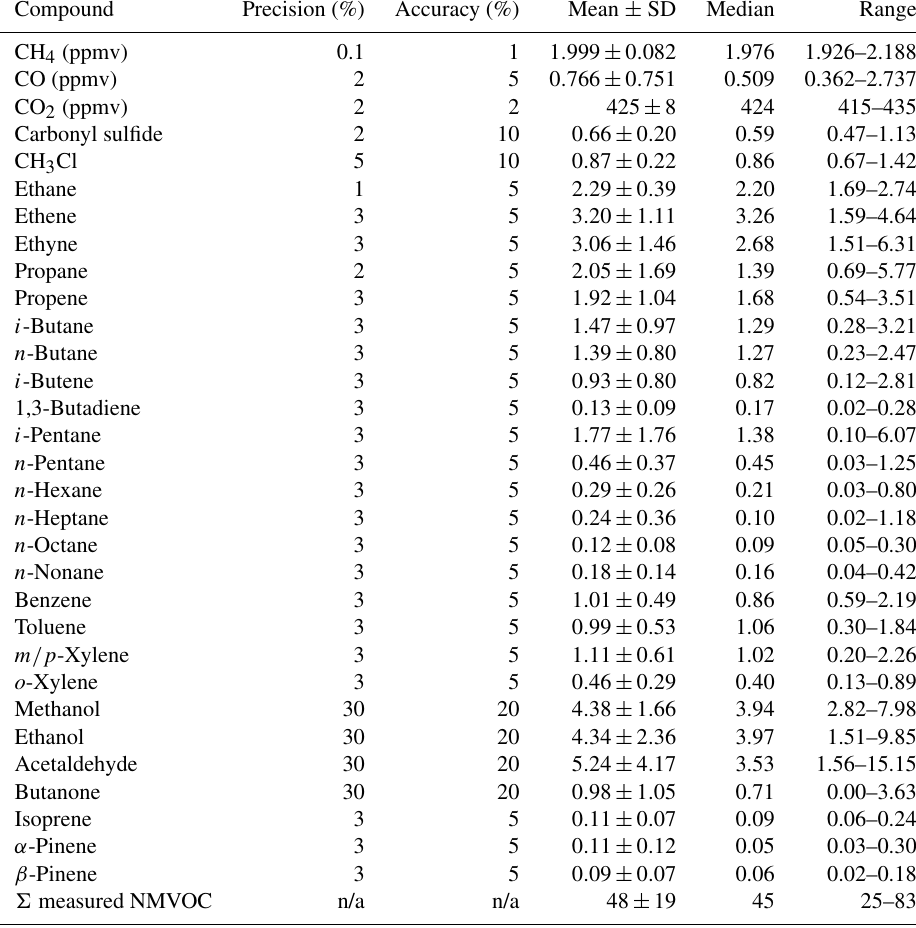
Table 2. Means, standard deviations, medians, and ranges of concentrations of methane, CO, CO 2 , carbonyl sulfide (COS), and select non- methane volatile organic compound (NMVOC) mixing ratios measured at Bode in April 2015 ( n = 9). Species reported here include the 20 most abundant species, with all NMVOC measurements provided in Table S1. Units are in parts per billion by volume, unless